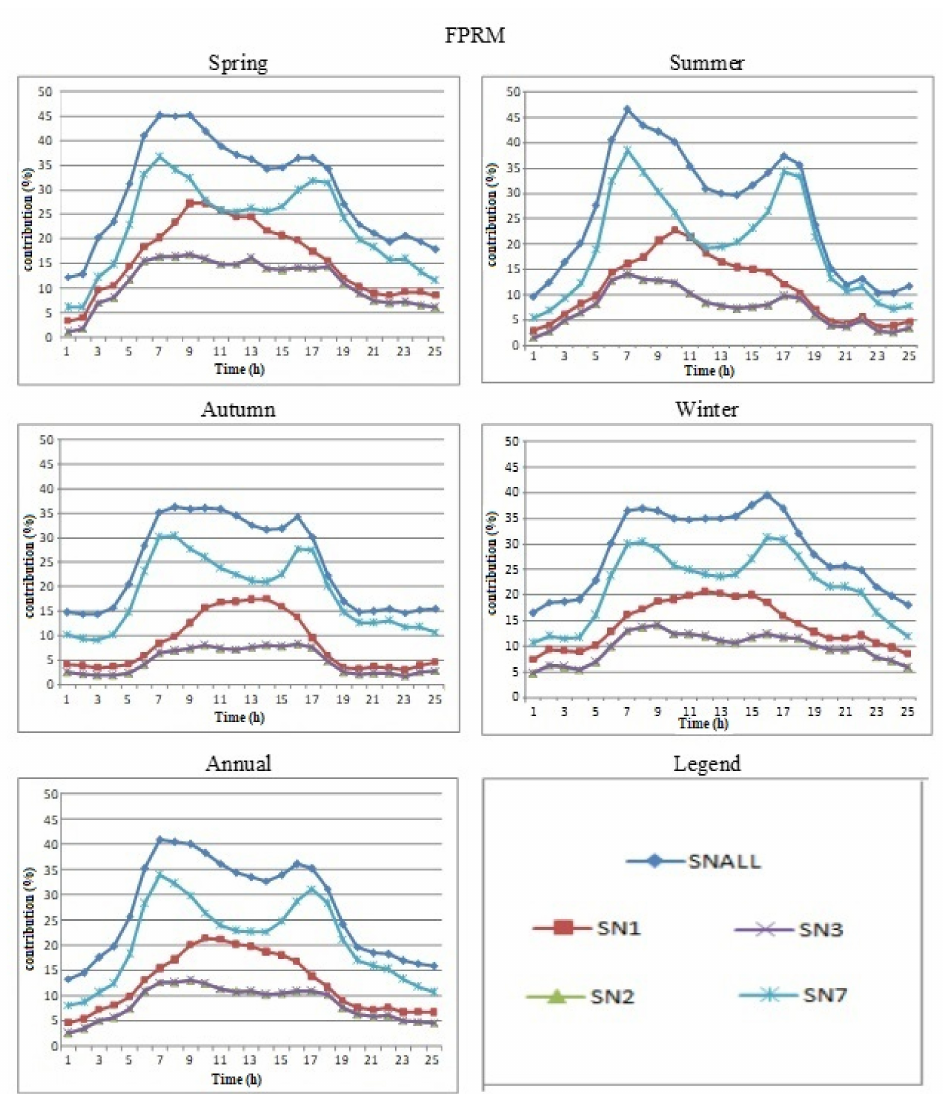
Figure 18. Annual and seasonal averaged relative contribution (%) of all the emissions and the emissions from different SNAP categories of the formation of FPRM concentrations for Bistritsa for the period